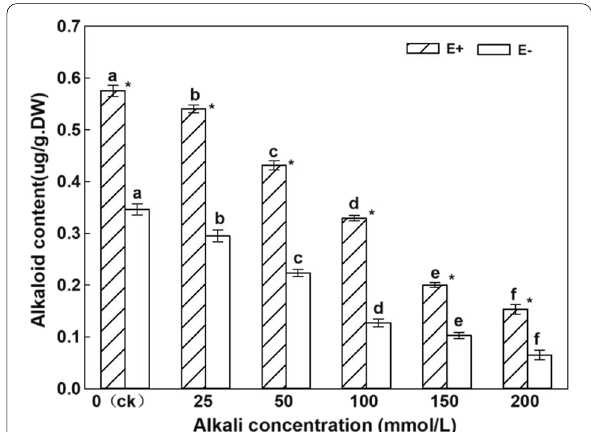
Fig. 4 Alkaloid content in the stems of E under different concentrations of alkali